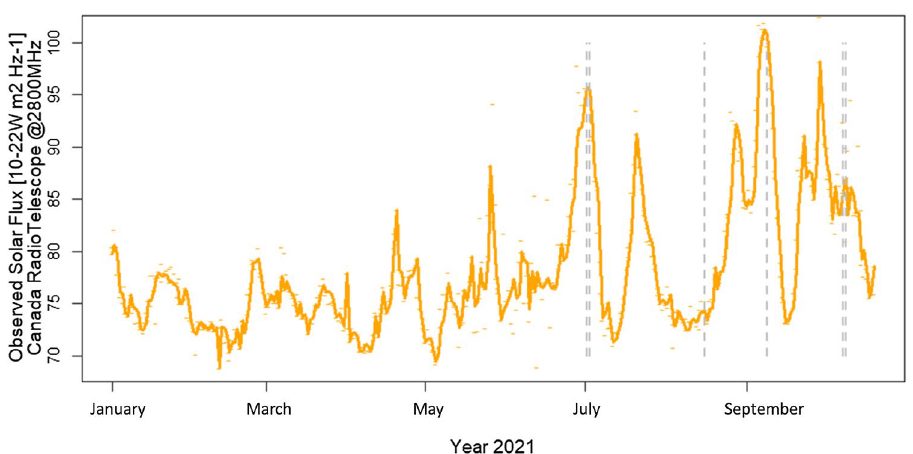
Figure 3. The Penticton F10.7 Index in 2021, and the 6 days (gray vertical lines) of July 2nd and 3rd, August 16th, September 9th, October 8th and 9th used to compare F10.7 Index with the disturbance derived from radiomobile MDT measures at 2.6